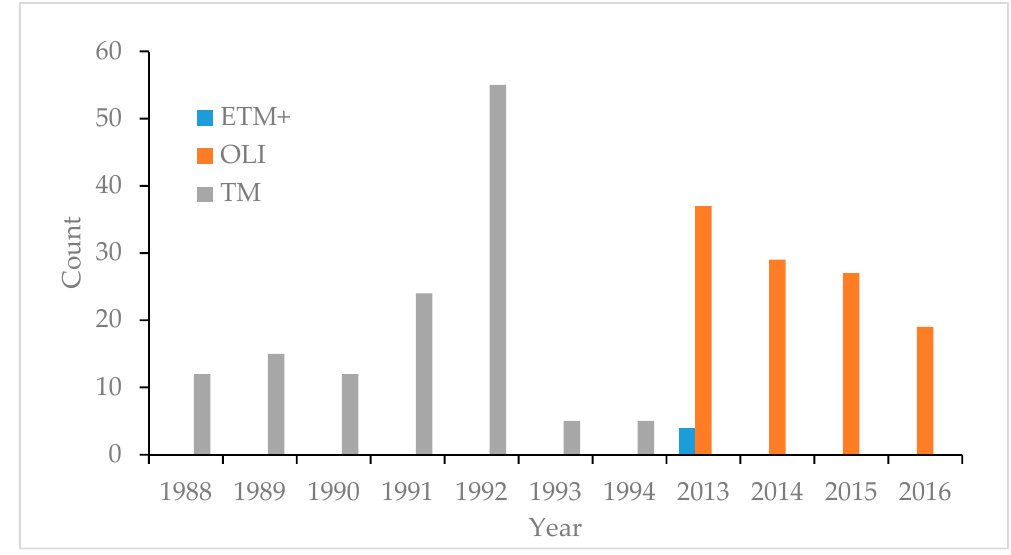
Figure 2. The annual distribution of Landsat images during two periods (the 1990s and 2015s).